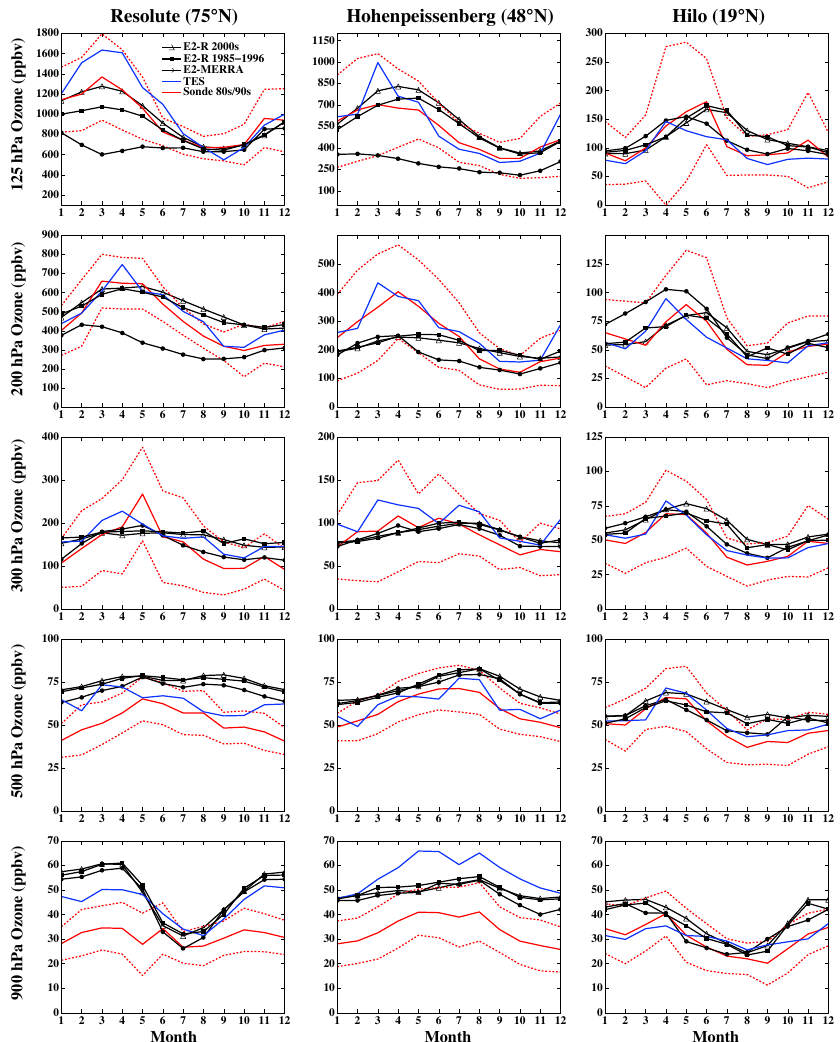
Fig. 2. Comparison of E2-R and E2-MERRA simulations with ozone sonde climatological station data (red, solid is mean and dashed is standard deviation) and with observations from the TES satellite instrument at the same locations. Sonde data from the first six stations shown is from ∼ 1985–1996, while from the last three stations is from the 2000s. TES data is from